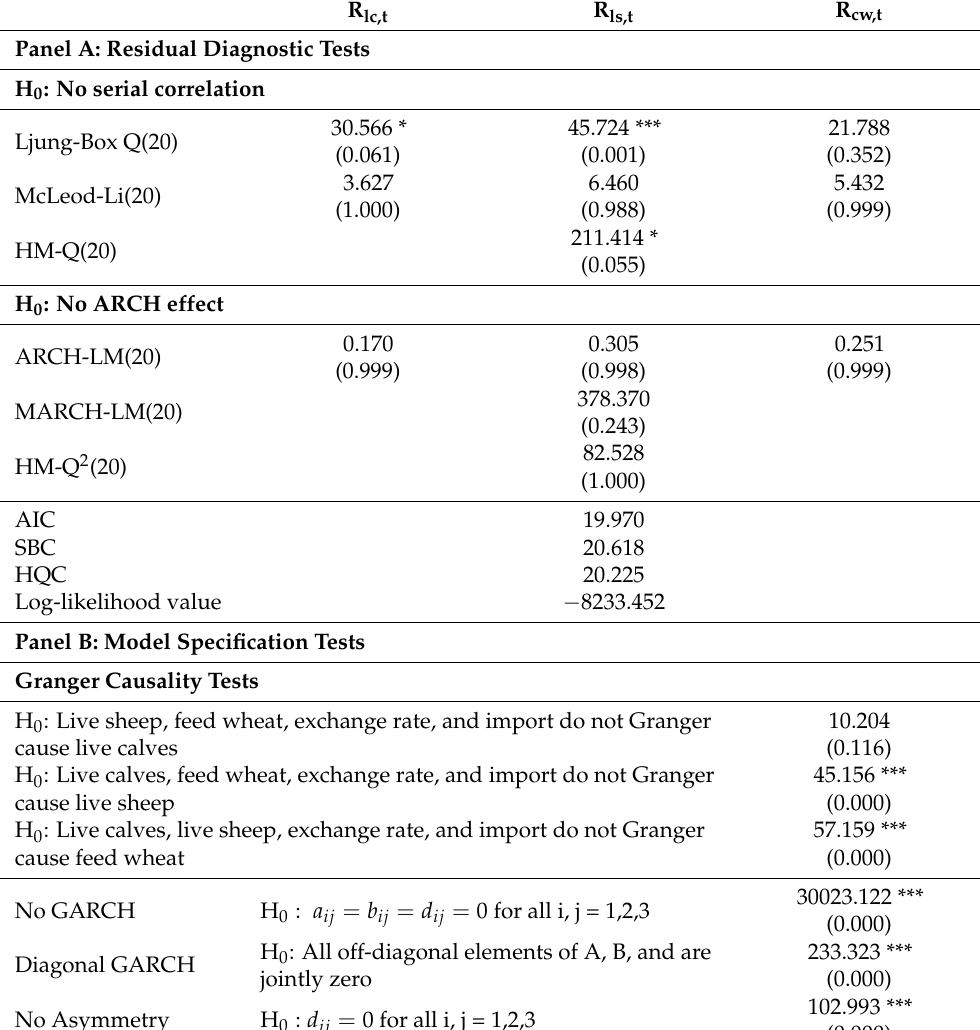
Table 3. Parameter estimates for conditional variances in VAR-Asymmetric BEKK